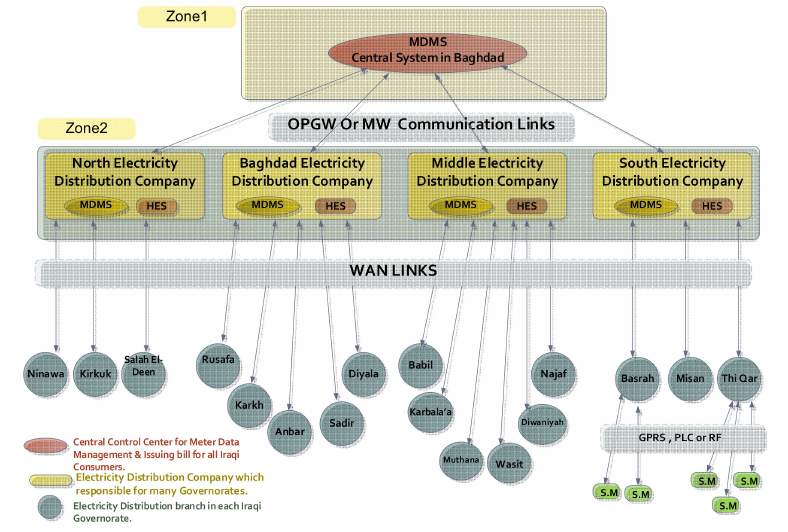
Figure 4. Proposal 2 of Iraqi MOELC SG-AMI